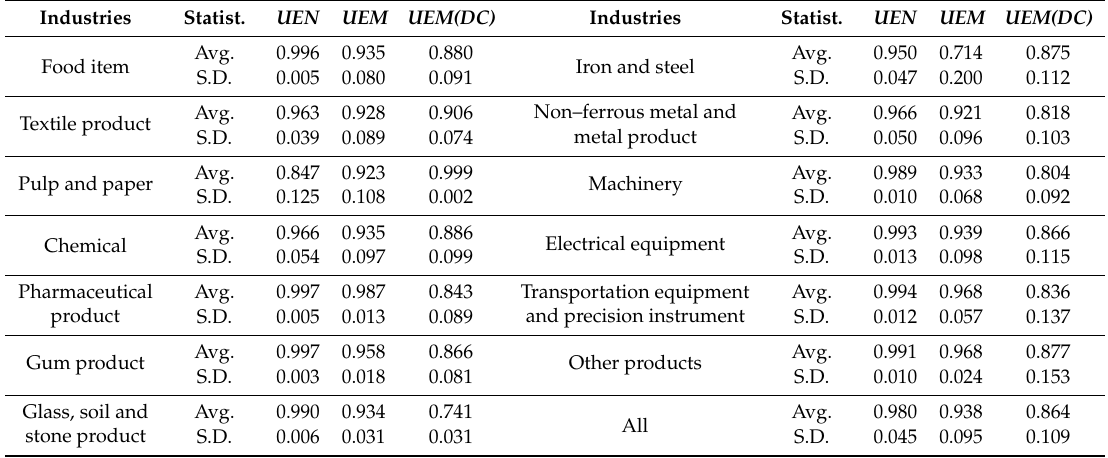
Table 4. Unified e ffi ciency averages of Japanese industrial